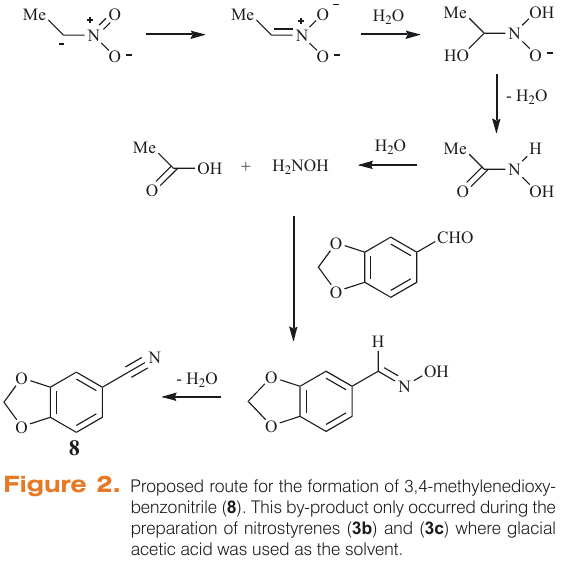
Figure 2. Proposed route for the formation of 3,4-methylenedioxy- benzonitrile ( 8 ). This by-product only occurred during the preparation of nitrostyrenes ( 3b ) and ( 3c ) where glacial acetic acid was used as the